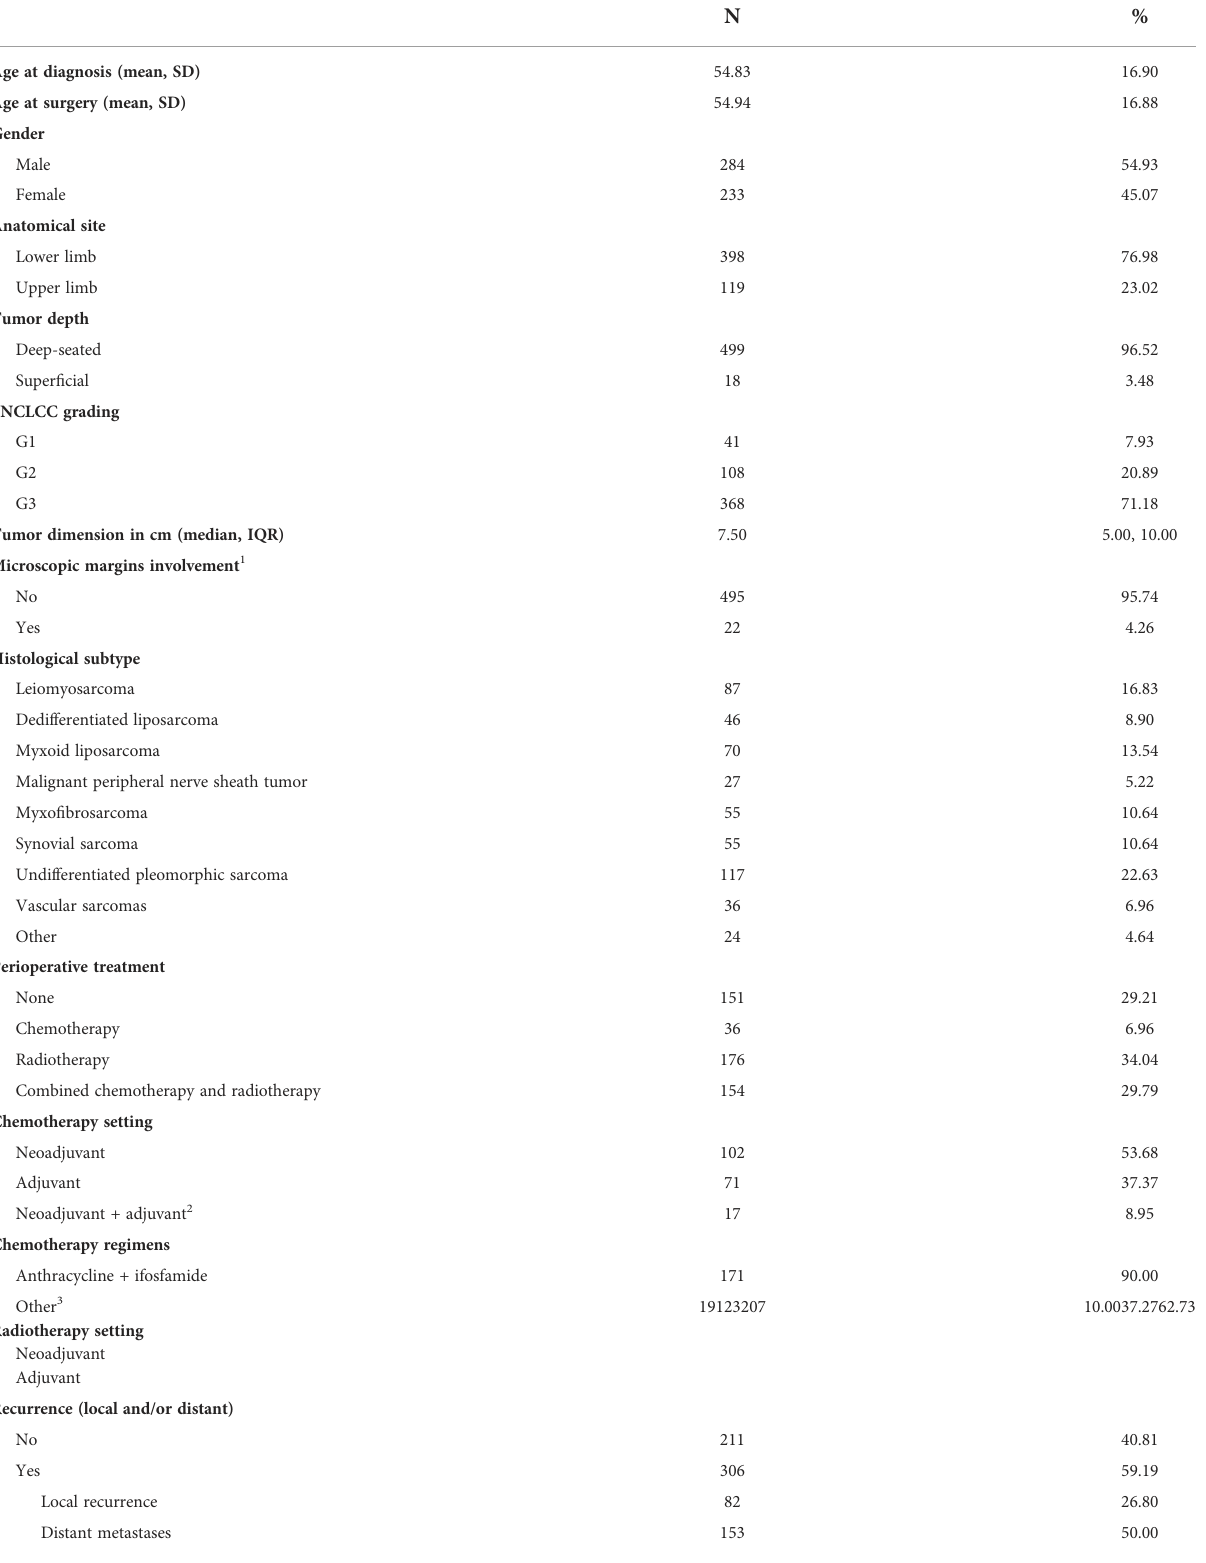
TABLE 1 Baseline characteristics of the patients who were included in the model building (n =